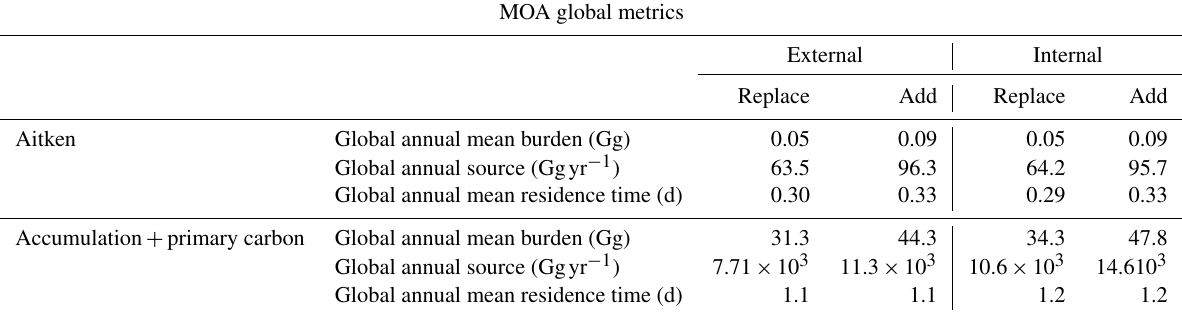
Table 4. Global atmospheric burdens, source terms, and residence times for MOA in the Aitken mode and the combined accumulation and primary carbon modes for each sensitivity case. Residence times are calculated as the global annual mean burden divided by total global annual losses due to wet and dry